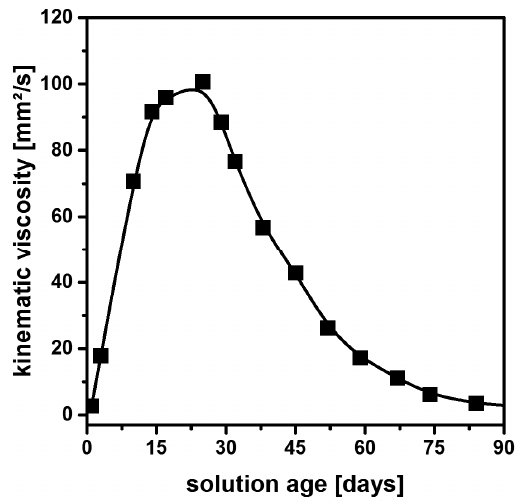
Figure 1. Viscosity of an MgF 2 precursor solution prepared from the reaction of Mg(OMe) 2 with anhydrous HF as a function of sol age. Based on [41].